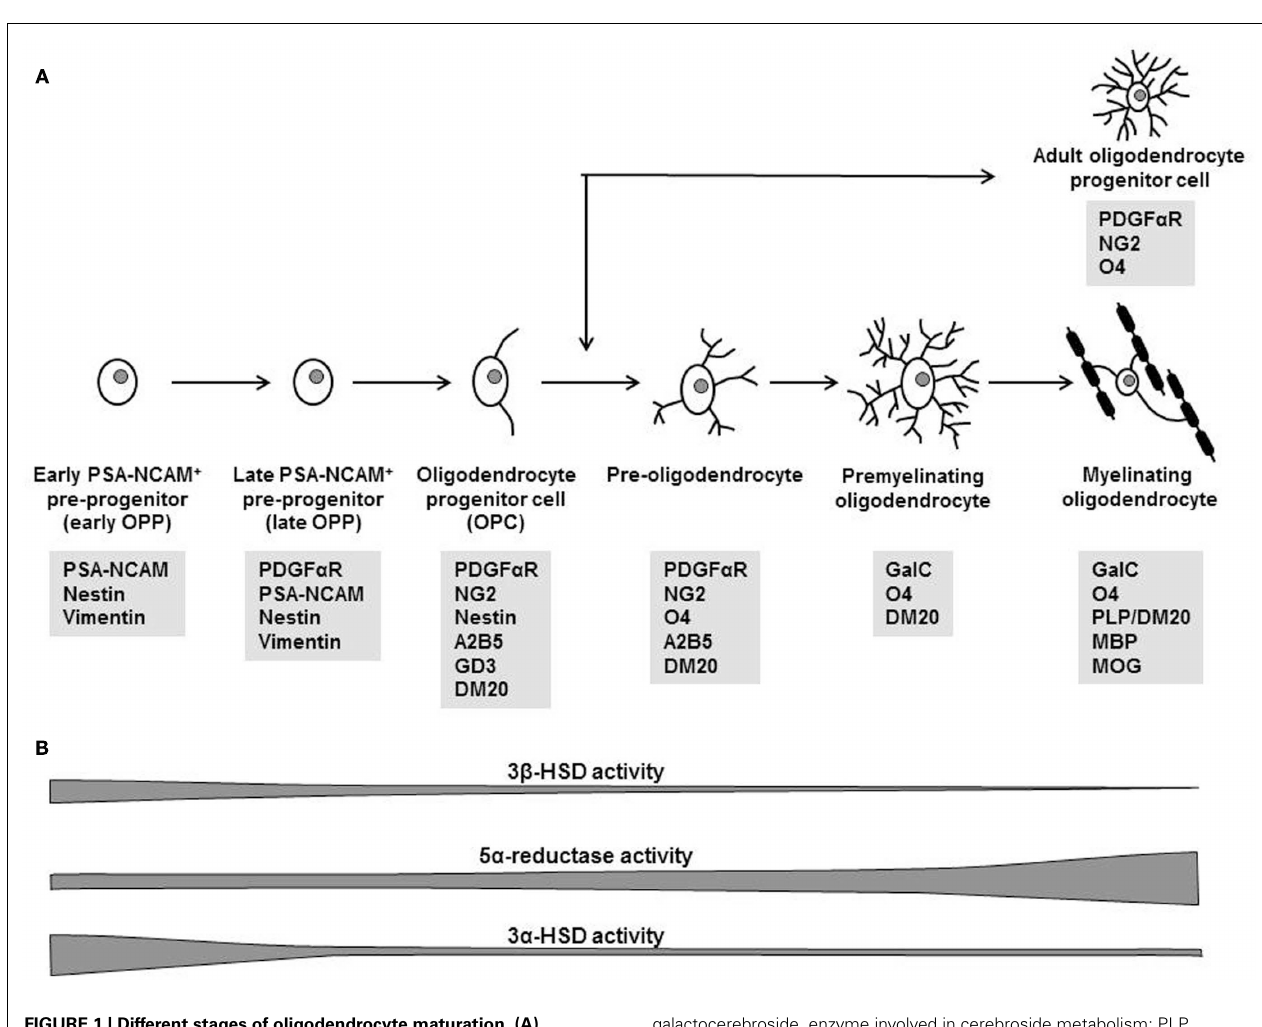
FIGURE 1 | Different stages of oligodendrocyte maturation. (A) Specific markers allow to identify the differentiation status of cells of the oligodendrocyte lineage (PSA–NCAM, polysialic acid-neural cell adhesion molecule; PDGF α R, platelet-derived growth factor receptor alpha; NG2, a membrane chondroitin sulfate proteoglycan; O4 antigen, cell surface sulfatide; A2B5 and GD3antigens, cell surface gangliosides; DM20, splice variant of the proteolipid protein; GalC,